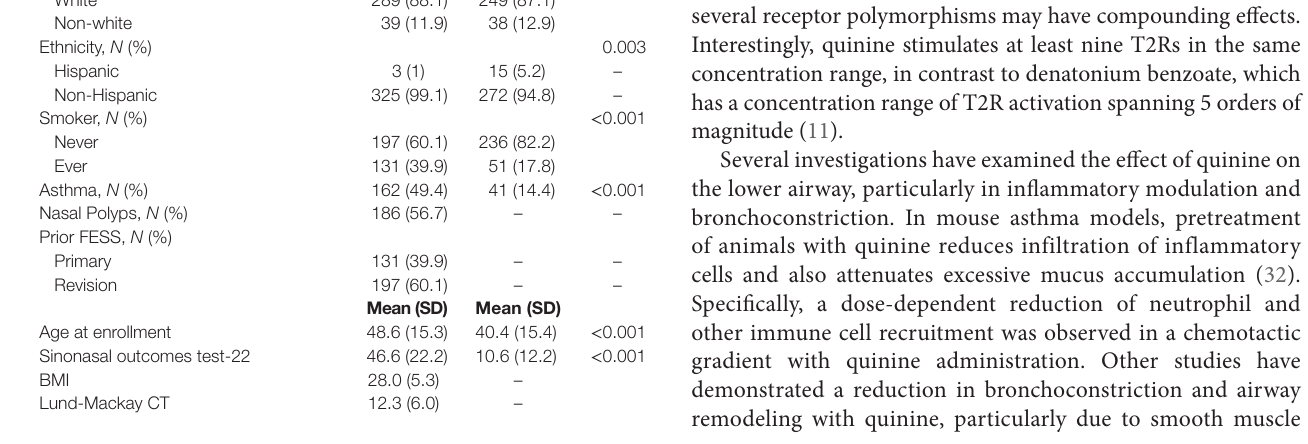
TaBle 2 | Left: Taste intensity testing results (raw mean score) in control, CRSsNP, and CRSwNP patients. Right: Propensity score modeling-adjusted differences between control and CRS groups reported as adjusted difference (standard error).